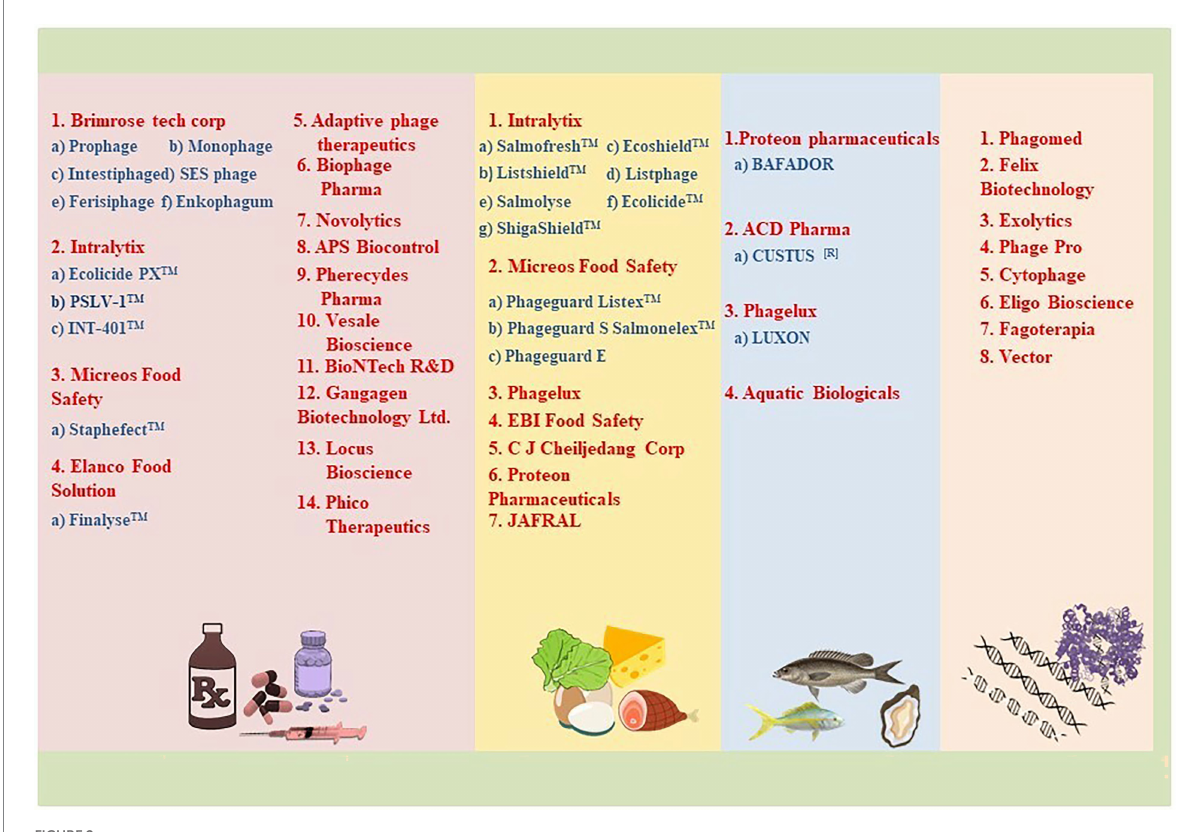
FIGURE 2 Illustration of companies involved in the production of natural and synthetic phage/phage-based products in various